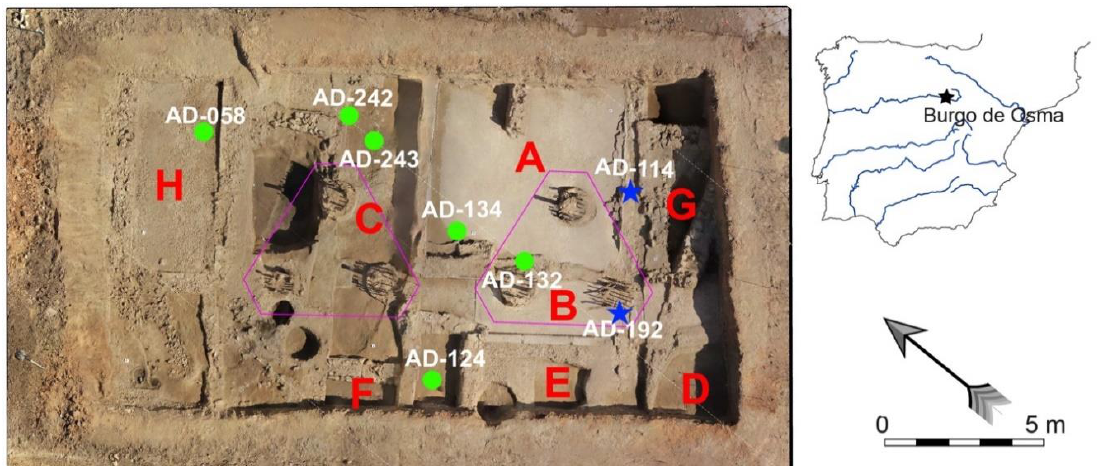
Figure 1. Excavation plan of Arroyo de la Dehesa de Velasco site (Burgo de Osma-Ciudad de Osma, Soria, Spain) and location of the samples in the labelled rooms (A, B, C, D, E, F, G and H). Purple shapes correspond to bridge footings traces of motorway A-11, green circles correspond to wall samples and blue stars to floor samples.